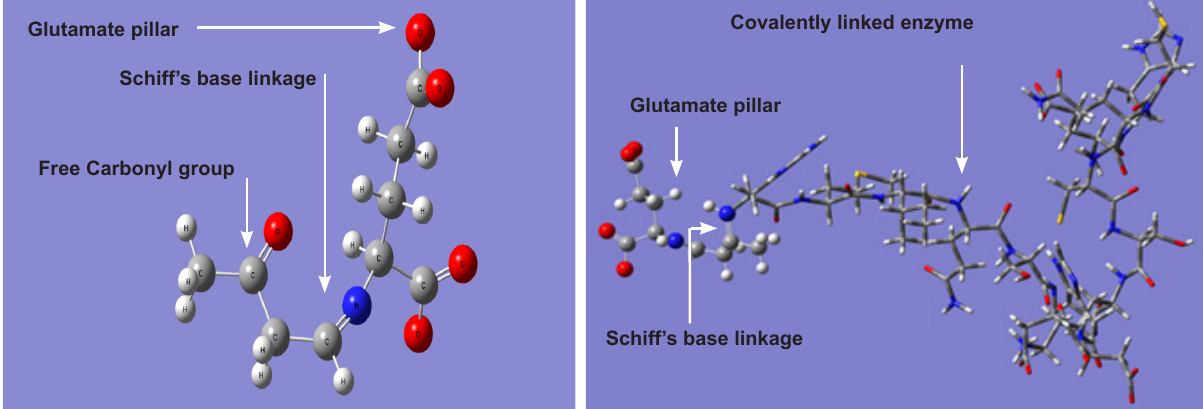
Figure 4: (a) Geometry optimized structure for the intermediate cross linked stage of GP-LDH (b) covalently linked enzyme to the dicarbonyl cross linker